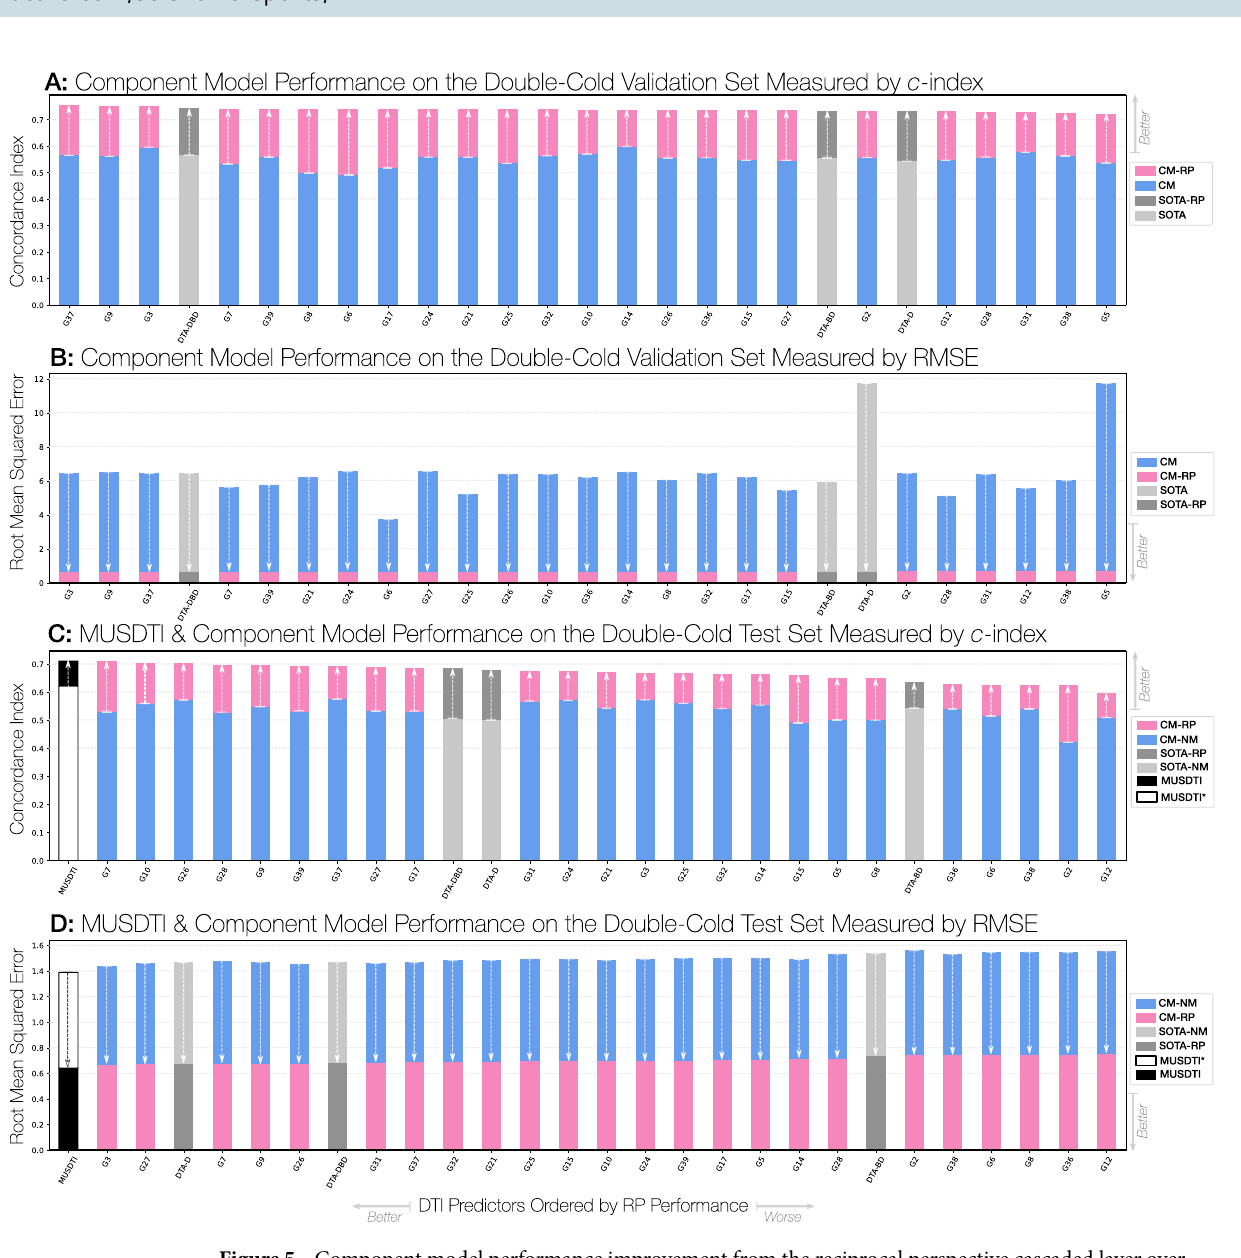
Figure 5. Component model performance improvement from the reciprocal perspective cascaded layer over the double-cold